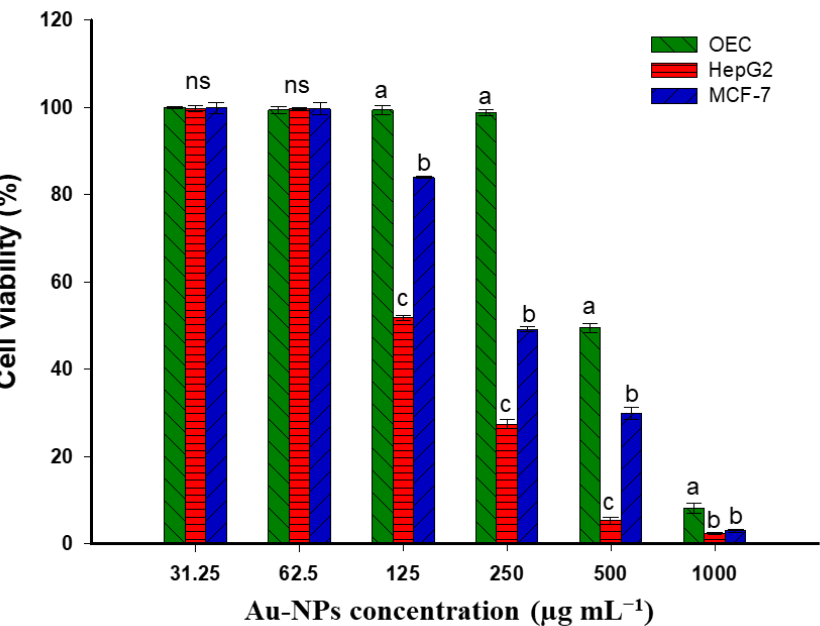
Figure 7. In vitro cytotoxic efficacy of phytosynthesized AuNPs against a normal cell line (OEC) and cancer cell lines (HepG2 and MCF7) evaluated by MTT assay method. Data represent average values ± SD (n = 3). Different letters on the bars at the same concentration indicated that the mean values are significantly different (at p ≤ 0.05); ns, the mean values are non-significantly different.